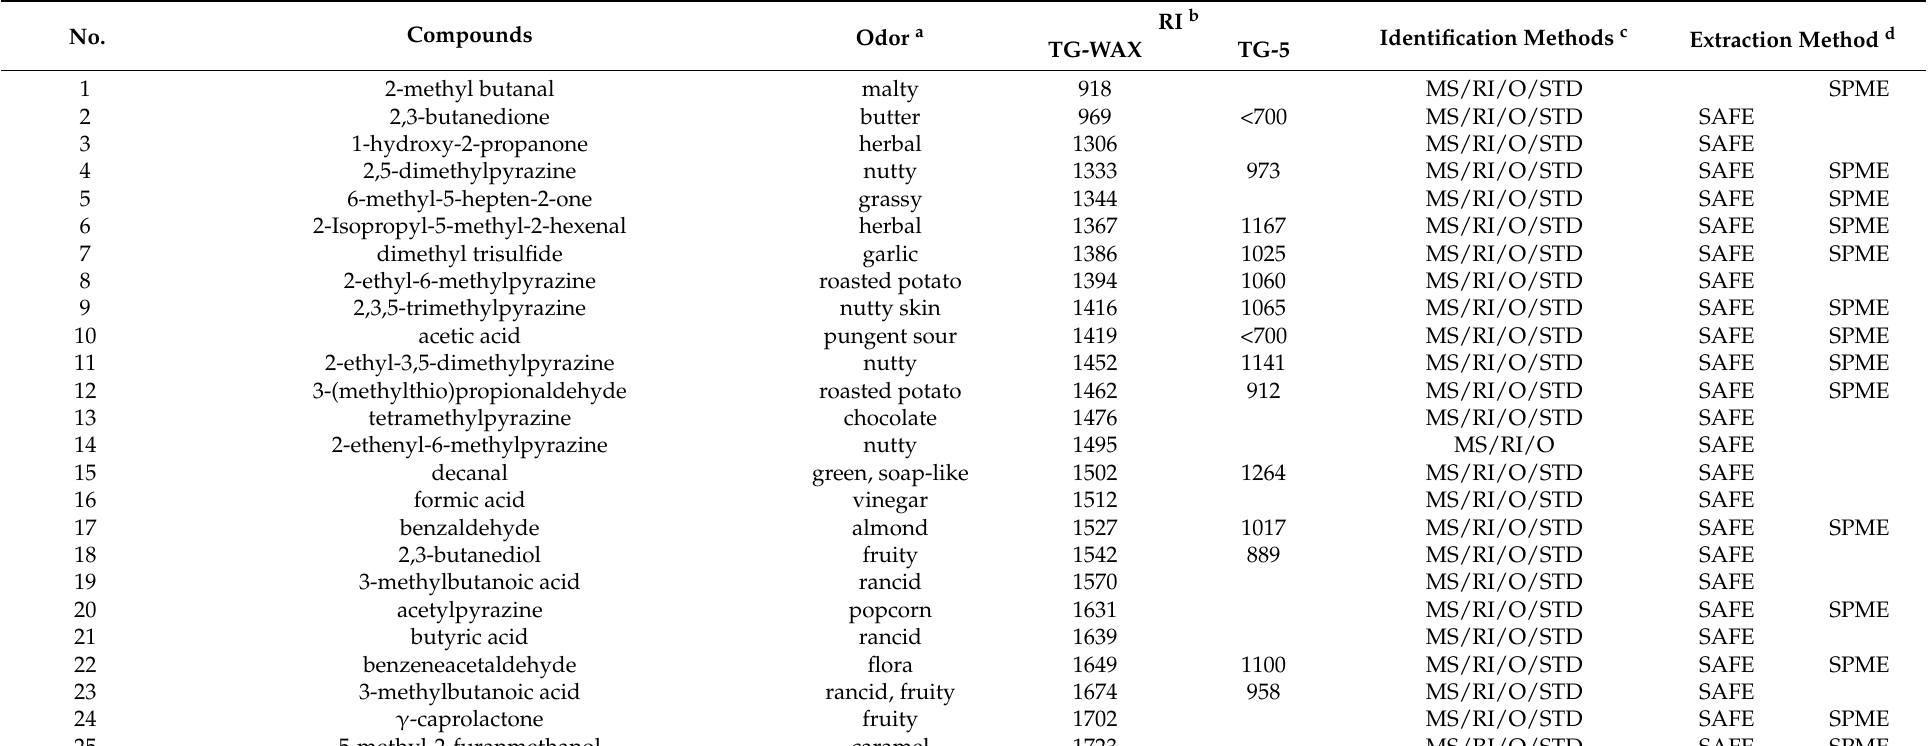
Table 1. Aroma compounds detected in Yongchuan